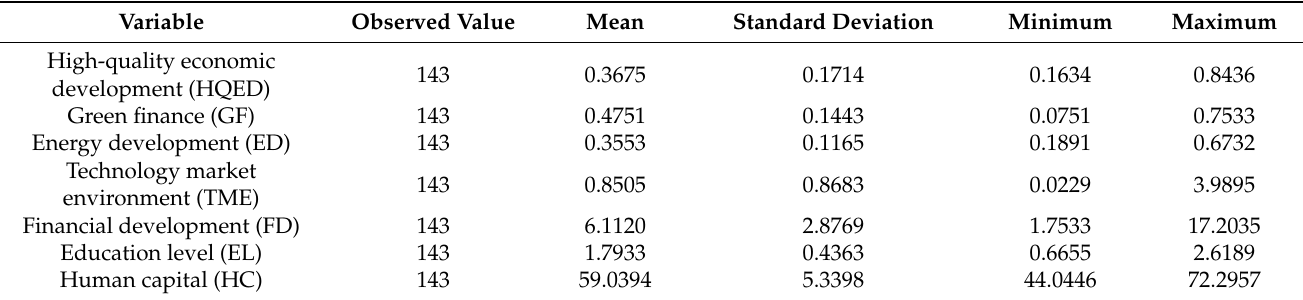
Table 3. Variable descriptive